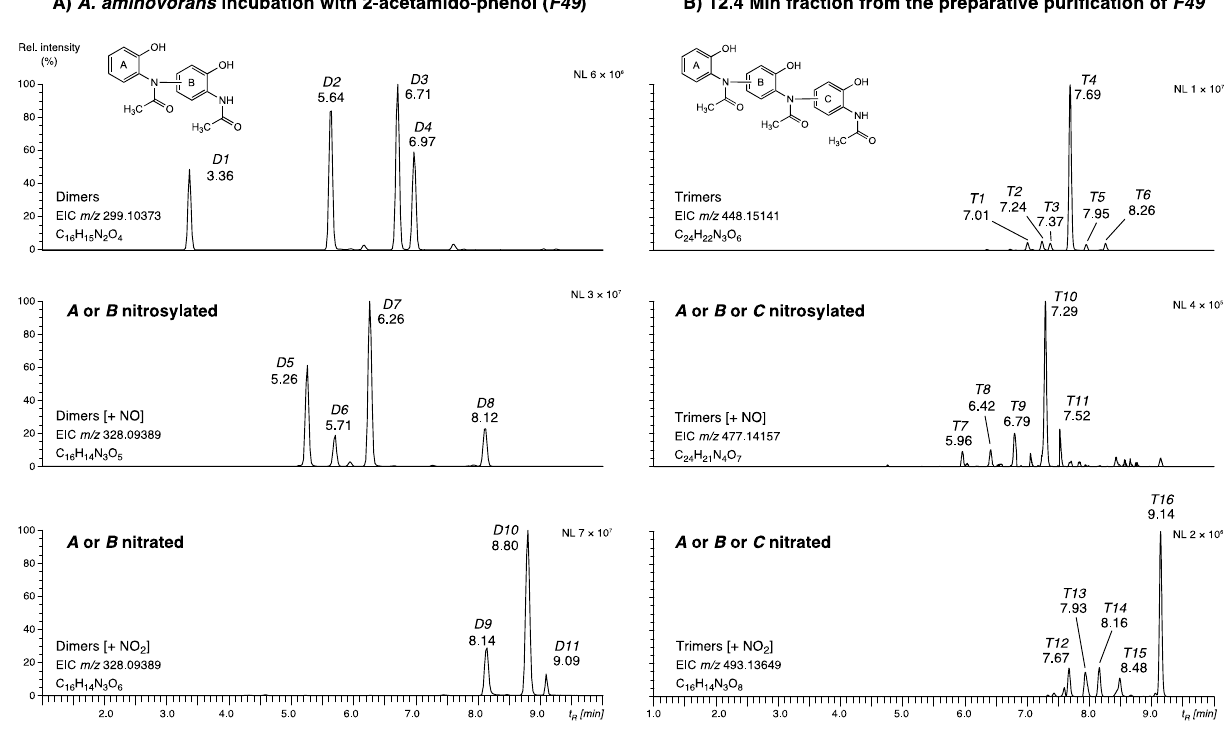
Figure 4. High-resolution extracted-ion chromatograms (EIC, ± 1.5 mDa) obtained from the LC-(–)- ESI-HRMS analysis of ( A ) fraction F49 , revealing dimers of 2-acetamido-phenol ( A : peaks D1 - D11 ) and their nitrosylated and nitrated derivatives and ( B ) fraction t R 12.5 min of purified F49 (Figure S3), indicating the presence of analogous trimers ( B : peaks T1 - T16